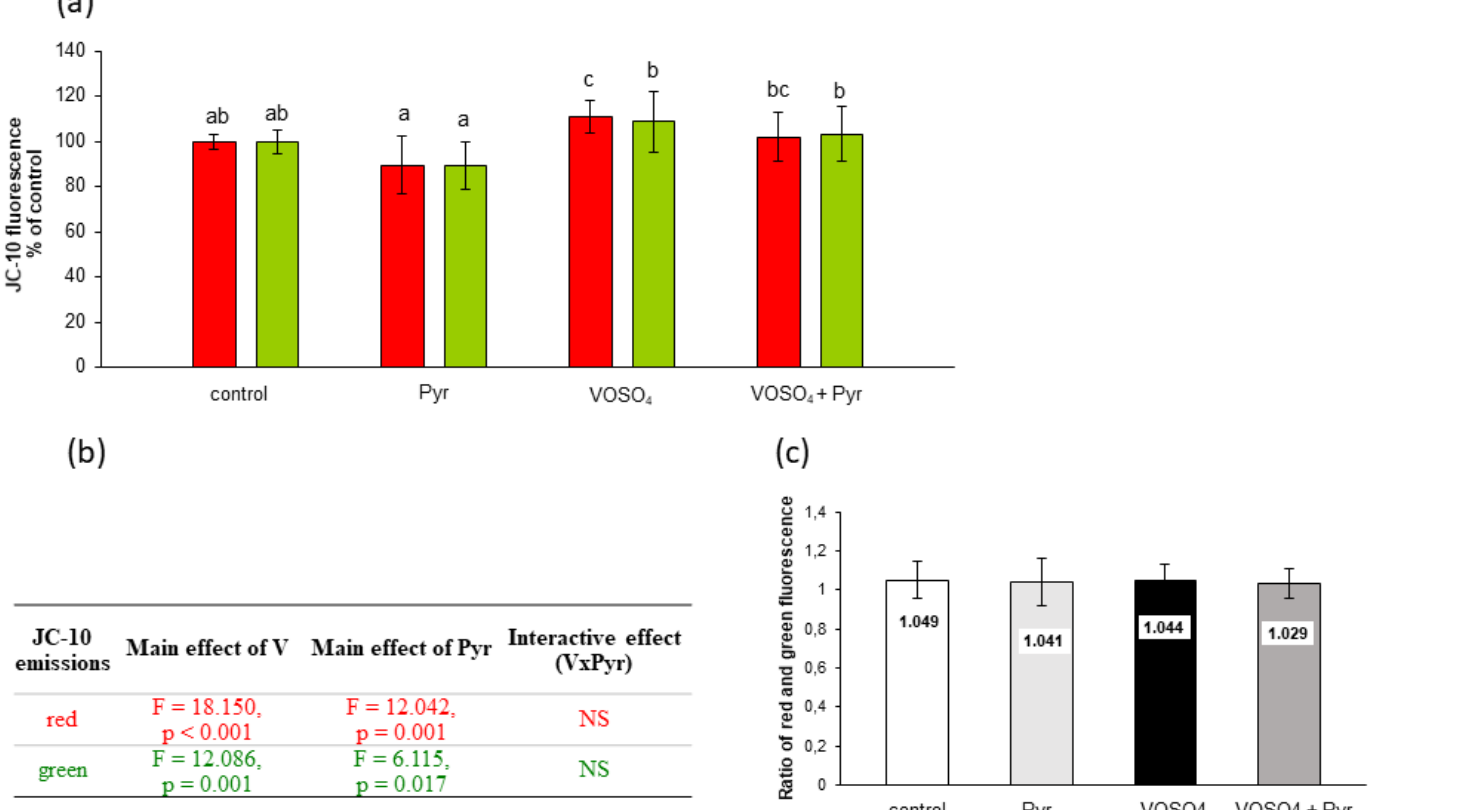
Figure 6. Effects of vanadium and/or pyruvate on MMP in CHO-K1 cells detected with the JC-10 staining method. The cells were incubated in DMEM/F12 medium without (control) or with 100 μM VOSO 4 in the presence or absence of sodium pyruvate (Pyr) (4.5 mM) for 48 h. ( a ) Red and green JC-10 fluorescence emissions expressed in percentage. Data represent the mean ± SD derived from 3 independent experiments each performed at least in triplicates. Means within the same color followed by a common letter are not significantly different. Data were analysed by one-way ANOVA followed by Dunnett’s T3 test; ( b ) Results of the two-way ANOVA analysis of red and green JC-10 fluorescence emissions after 48-h exposure to V (as VOSO 4 ) and Pyr (pyruvate), NS: no significant effect; ( c ) red/green fluorescence intensity ratio.